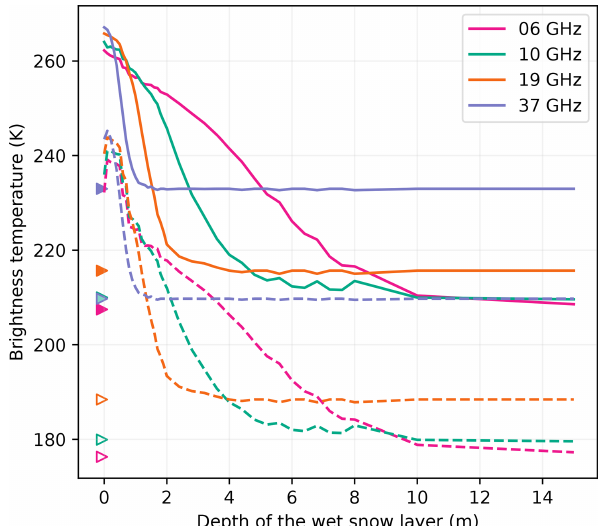
Figure 11. Brightness temperature of a wet snowpack as a function of the depth of a 10cm thick wet snow layer at Roi Baudouin at V-pol (solid curves) and H-pol (dashed curves). Each curve is the average of the 100 best snowpacks to smooth the curves. The values of the dry brightness temperatures are marked by the triangles.